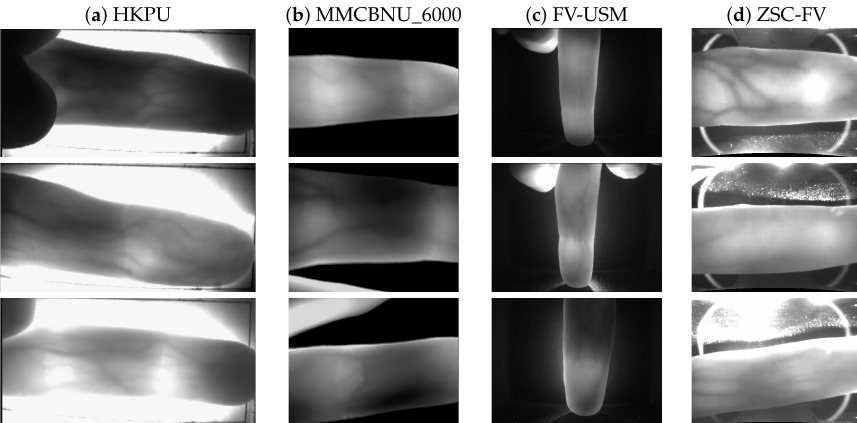
Figure 5. Three different qualities of images from the four different datasets. The first row corresponds to the good quality, the second row to the medium quality, and the third row to the poor